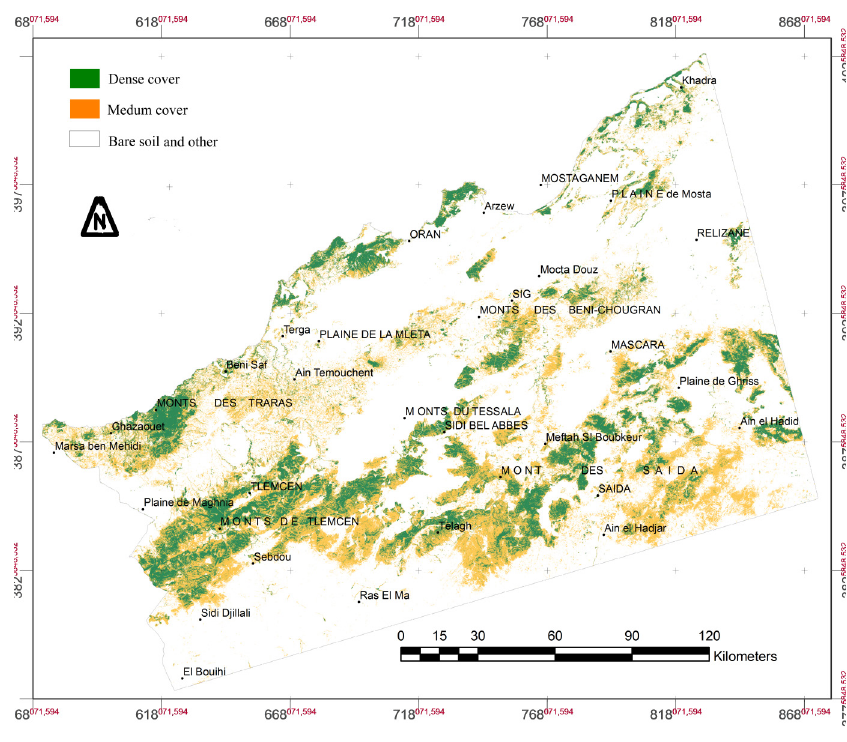
Fig. 7. Vegetation cover,